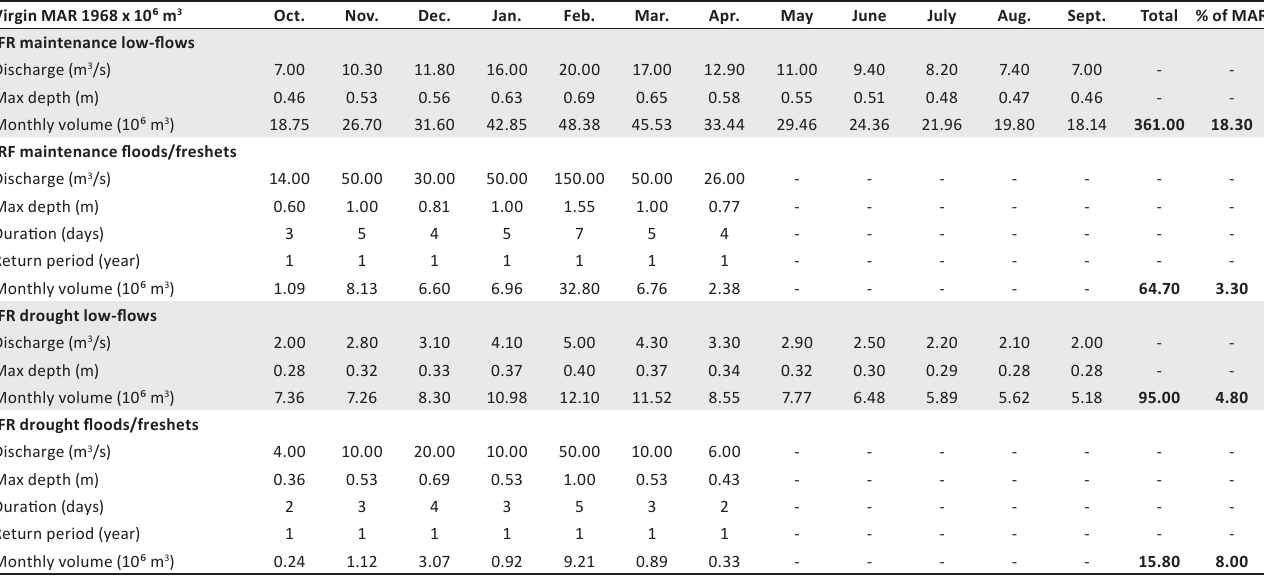
TABLE 1: In-stream flow requirements, as determined for the Kruger National Park rivers using the ‘Building Block’